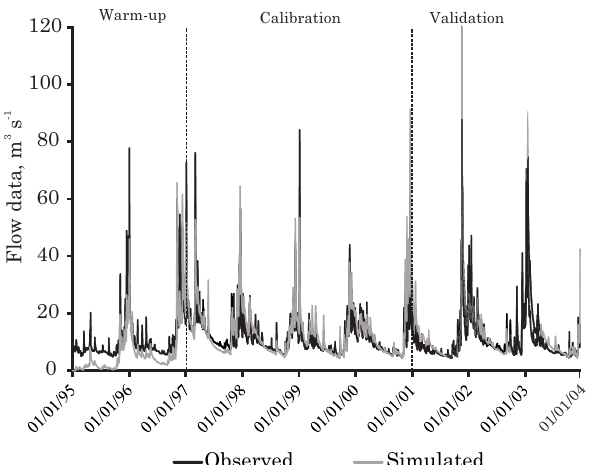
Figure 2. Warm up, calibration and validation periods of the SWAT model.